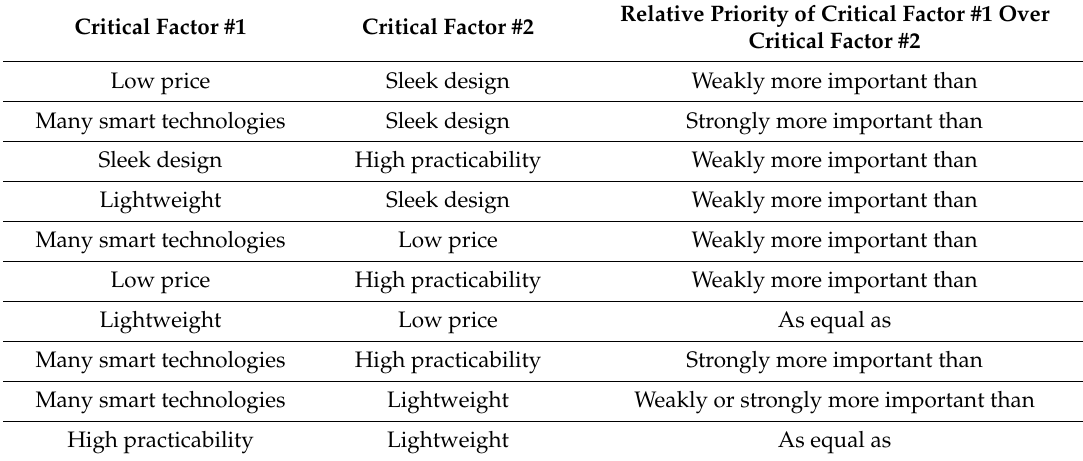
Table 4. Results of pairwise